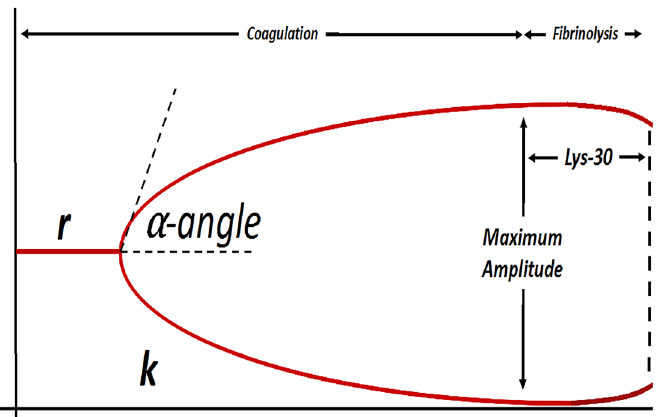
Figure 1. Example of thromboelastogram analysis curve (adapted from Stravitz et al, 2012 26